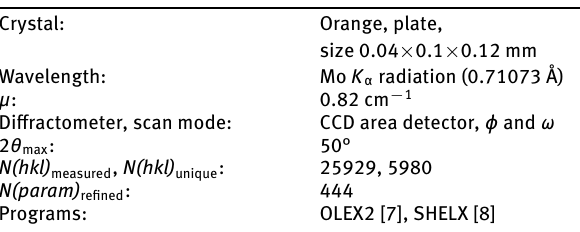
Table 1: Data collection and handling.